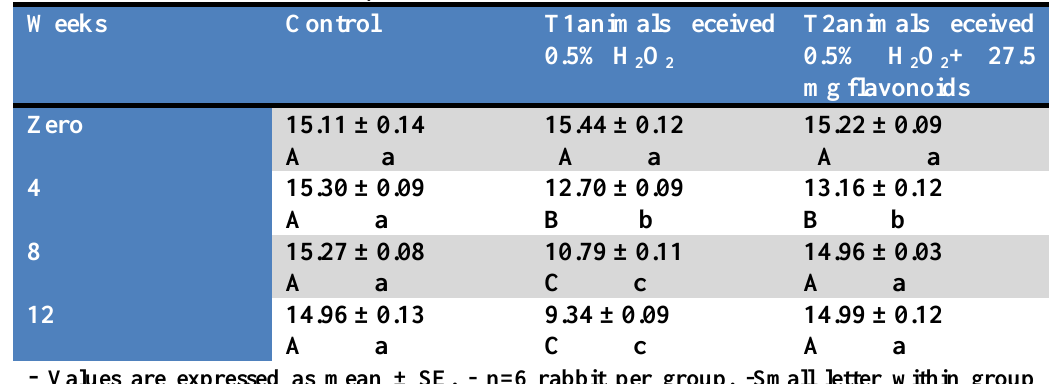
Table (4): Effect of flavonoids extracted from black cumin seeds for twelve weeks on